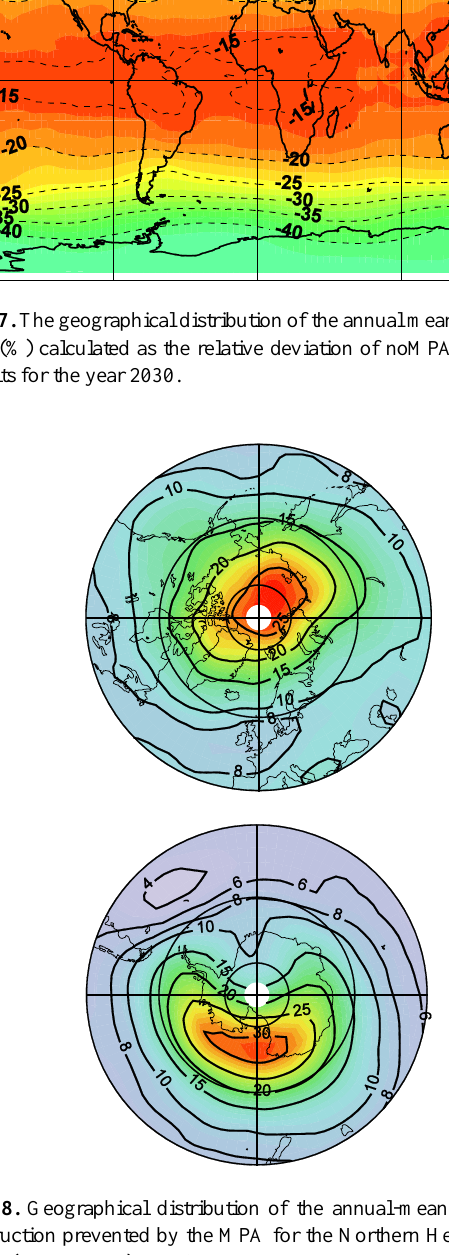
Fig. 8. Geographical distribution of the annual-mean total ozone destruction prevented by the MPA for the Northern Hemisphere in 2009 (upper panel) and for Southern Hemisphere in 2003 (lower panel). The values for isolines in percent are: 4, 6, 8, 10, 15, 20, 25.